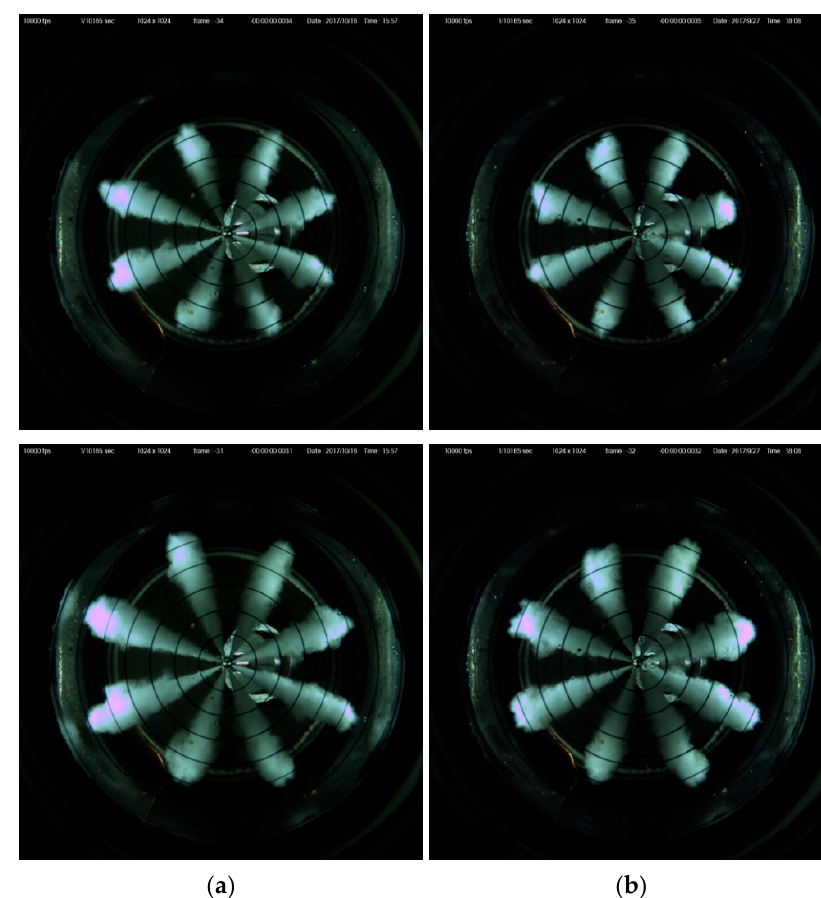
Figure A2. Development of fuel sprays in a constant volume chamber with nozzle 1 ( a ) and nozzle 2 ( b ) with a rail pressure of 130 MPa.